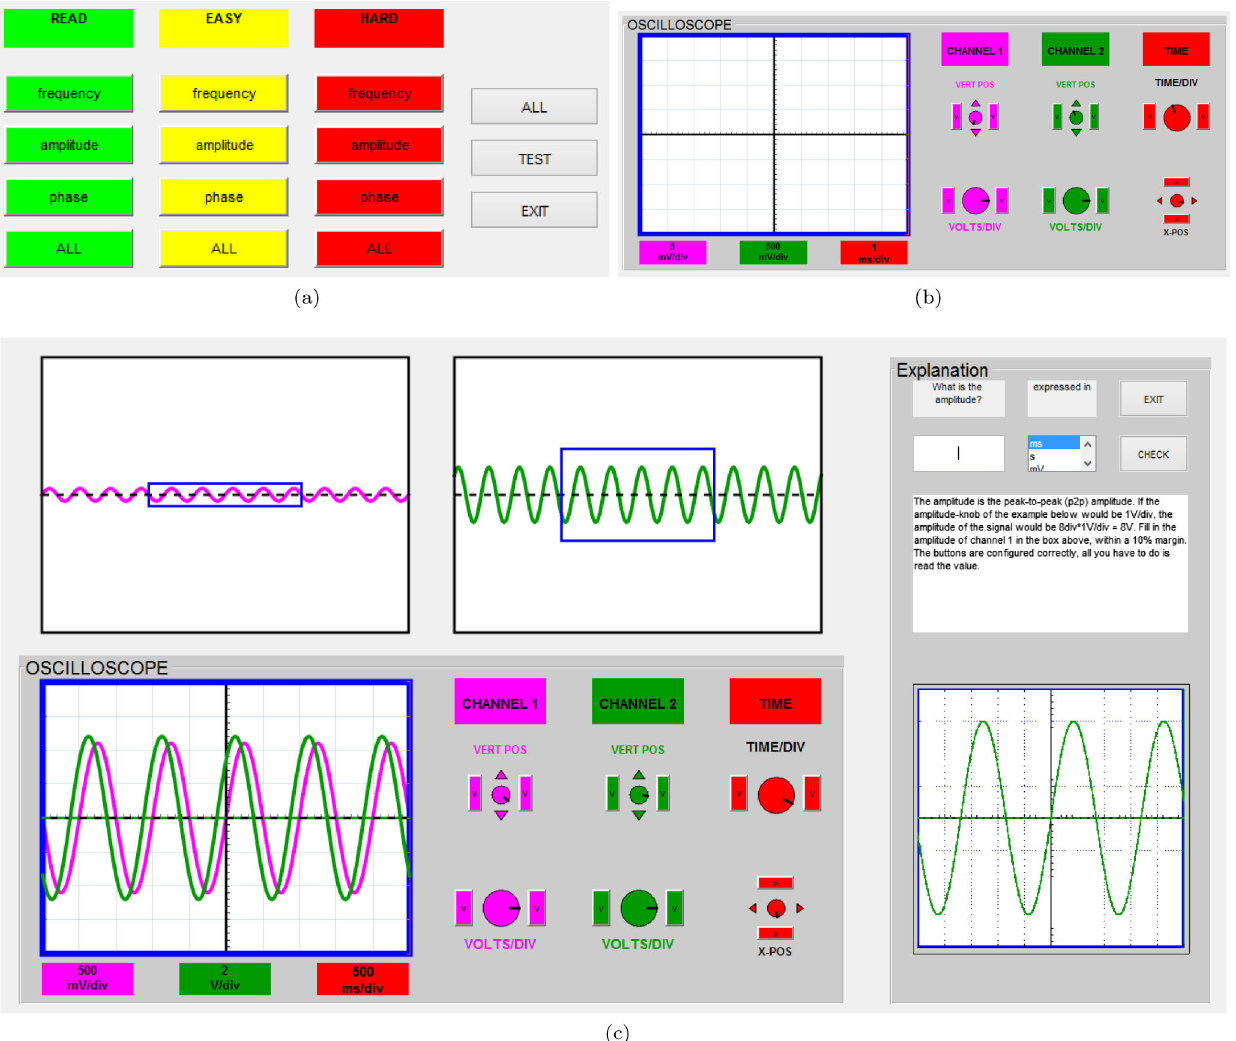
FIG. 8. Final version of the simulator. (a) In the first screen, the student can choose to practice reading a parameter at various levels of difficulty [well-configured oscilloscope, one setting (amplitude or time) misconfigured or fully misconfigured (both amplitude and time) scope] or to show the test to hand in at the beginning of the lab. (c) In the practice scope, there is an explanation about how to measure a parameter. The student can subsequently fill in the measurement value and choose the unit, after which the simulator will say whether it was correct or not. The test (b) now only shows the oscilloscope screen with two signals that the student has to measure. The measurements are to be handed in at the beginning of the